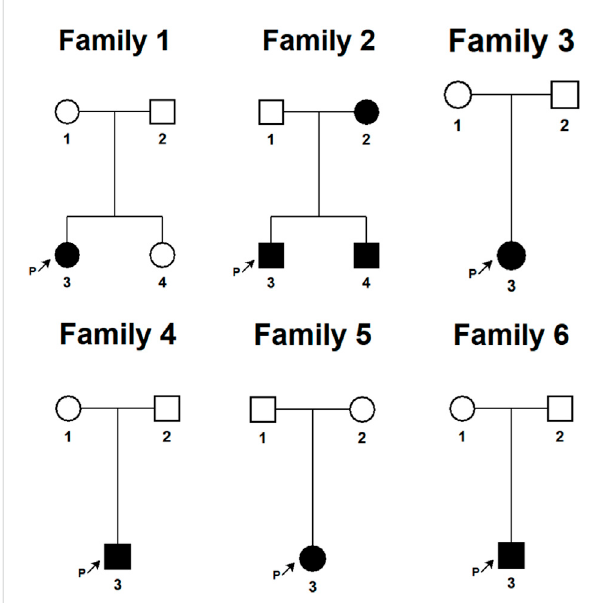
FIGURE 1 The pedigree Gram of six Chinese Han pedigrees of isolated CALMs. The proband was marked with the arrow. Males were indicated by squares; Females were indicated by circles. Blackened symbols represented patients who had